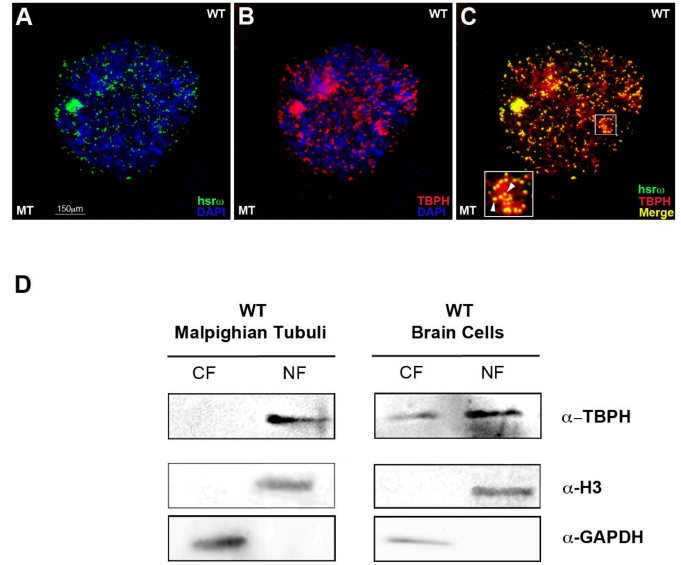
Figure 2. Immuno-FRISH showing that TBPH physically interacts with the hsr ω arcRNA in vivo. ( A – C ) Immunostaining for TBPH (red) combined with FRISH for hsr ω RNA (green) on wild-type (WT) in MT partial squashed nuclei. Arrowheads in higher magnification white box in ( C ) show co-localization points between TBPH protein and the arcRNA (single nuclei are shown in detail as representative of several observations across 3 biological replicates). ( D ) TBPH protein distribution between the nucleus and cytoplasm is different in WT tissues: in MT tissues (left panel) TBPH is in the nucleus (NF) while in BCs cells (right panel) the protein is present both in cytoplasm (CF) as well as in the nucleus (NF). Anti-GAPDH and anti-H3 were used as internal control to normalize CF and